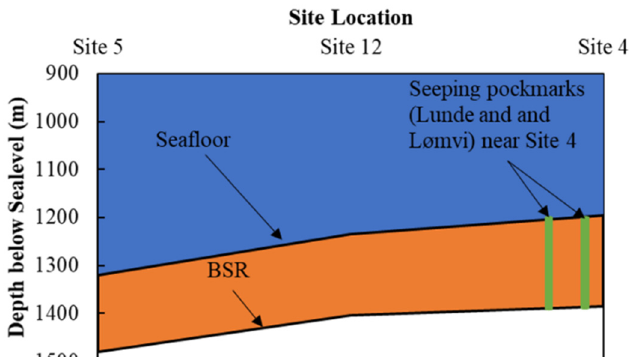
Figure 4. Seafloor and BSR depths for Sites 5,12 and 4 described in this study. The representative locations of the active seeping pockmarks (Lunde and Lømvi) near Site 4 are shown